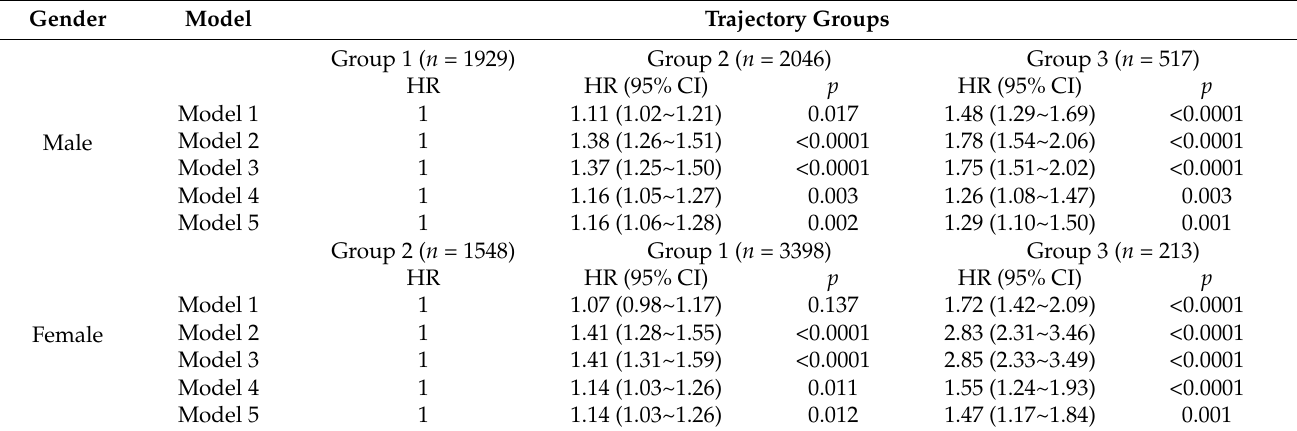
Table 2. Associations between WC trajectories and the risk of hypertension by gender.